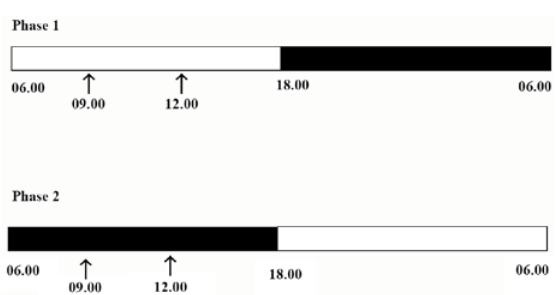
Figure1. Scheme of adaptation to the LD cycle. Light part of the day – empty column, dark part of the day – full column. Arrows indicate the running time of the